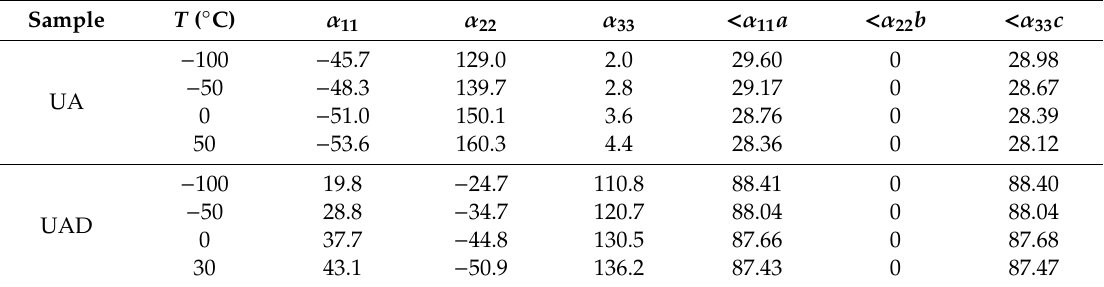
Figure 7. ( a ) Powder X-ray diffraction patterns and ( b ) the unit cell parameters of UAD as a function of temperature (30–100 °C) under heating in air: blue diamonds = SCXRD data, red squares = PXRD data; ESDs of the unit cell parameters are within the limits of the symbols. Table 3. The main coefficients of the thermal expansion/contraction α ii ( i = 1–3) × 10 6 °C – 1 and orientation of the main axes in the structures of UA and UAD.